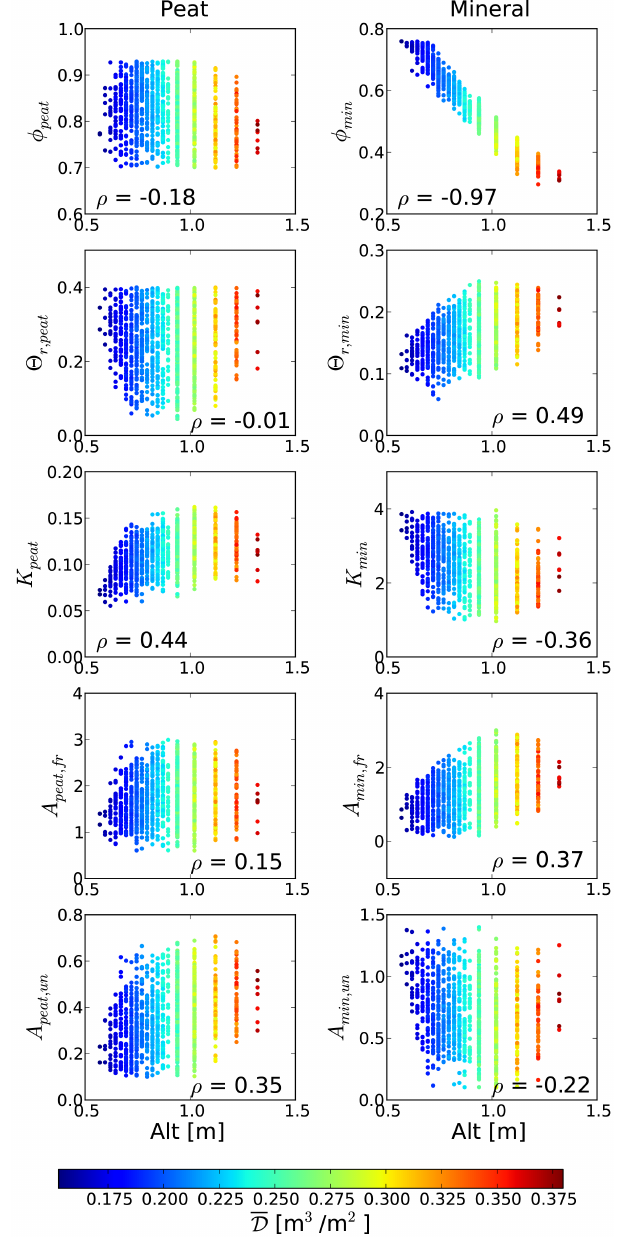
Figure 9. Scatterplots between calibration-constrained parameters and projected ALT for year 2100. Soil parameters associated with peat are on the left and with mineral soil on the right (refer to col- umn headings). Colors represent annual thaw depth-duration. The associated Pearson correlation coefficient ρ is indicated in each plot. discretization.